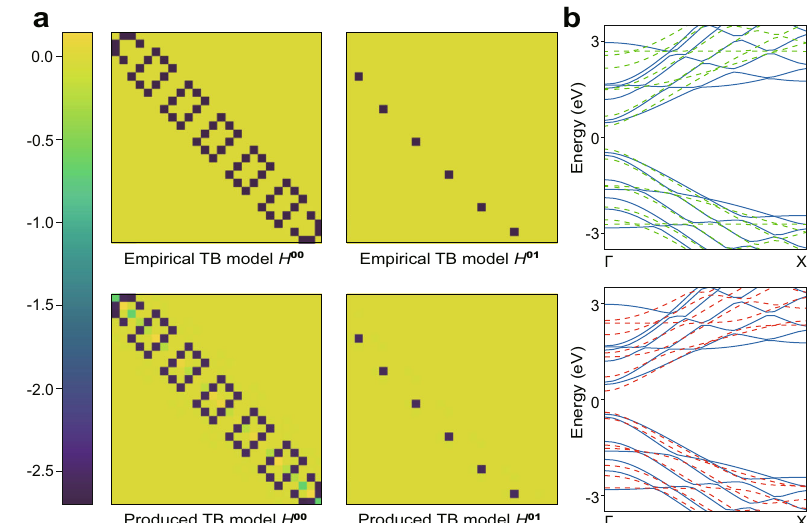
Fig. 7 The TB Hamiltonians for 13-AGNR in Slater – Koster form constructed from Variation II. a Comparison of the Hamiltonian elements of the produced TB model in Slater – Koster form and the empirical TB model. b Comparison of the ab-initio band structure (blue lines) and those calculated from the produced TB model (red dashed lines) and empirical TB model (green dashed lines) for 13-AGNR.